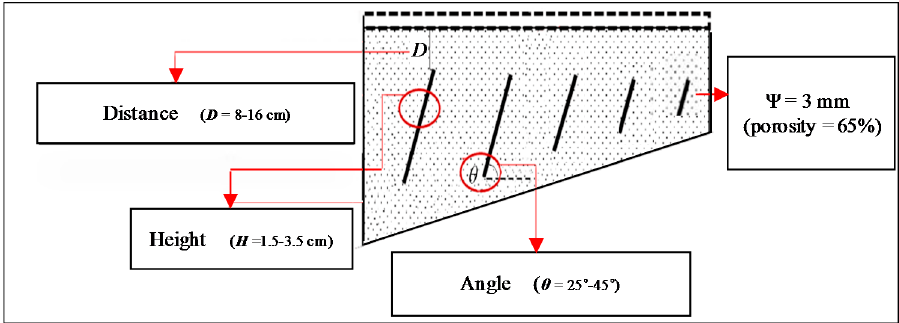
Figure 2. Three experiential parameters for the dry coal separation.